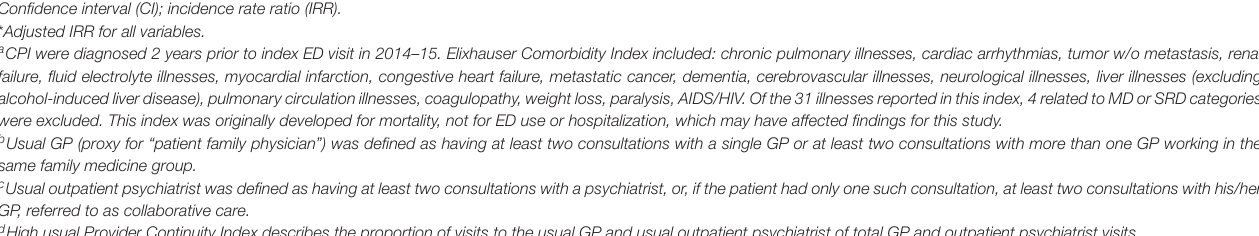
Patient group with MD and CPI (ref.: patient group with MD